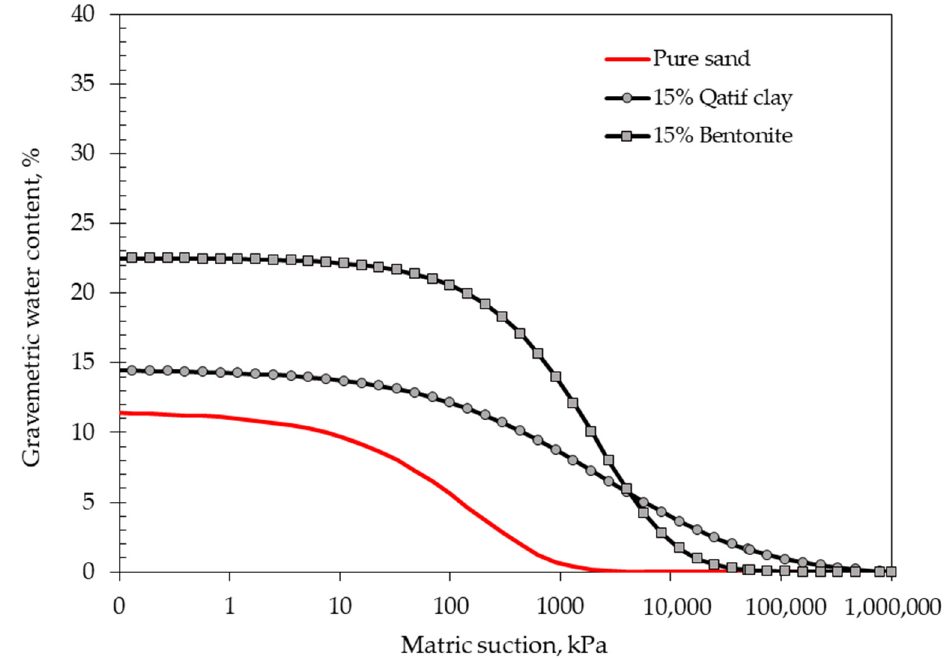
Figure 6. Soil-water retention curves for liner mixtures.